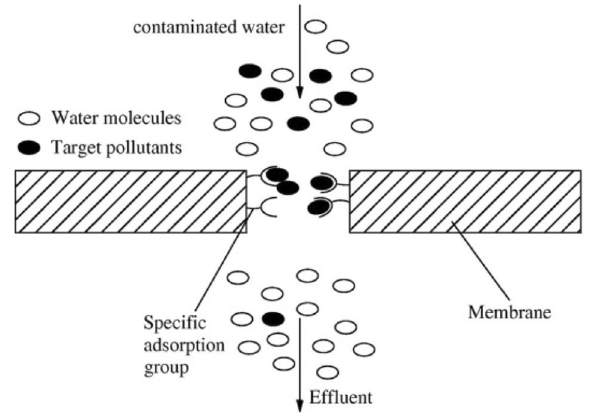
Fig. 1 The principle of membrane